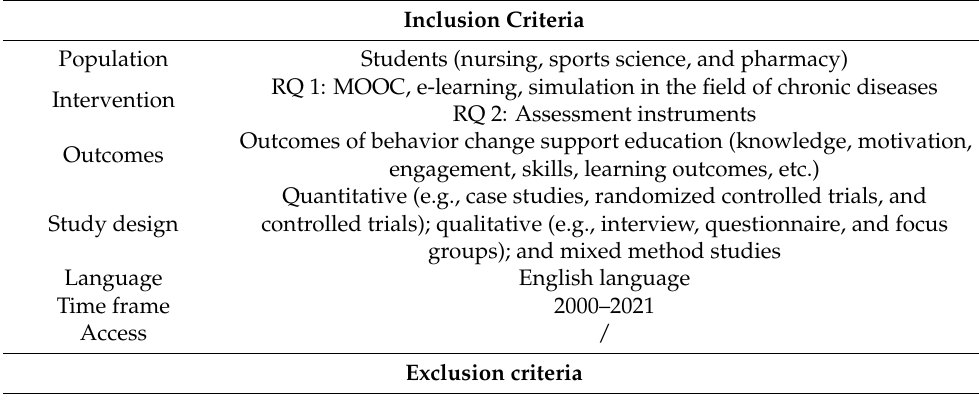
Table 1. Inclusion and exclusion